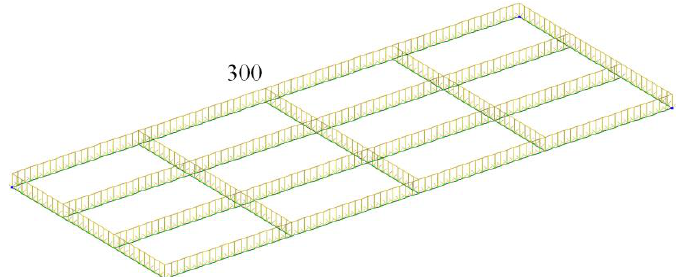
Figure 2. Design diagram of the module at loading Diagram I (kN).